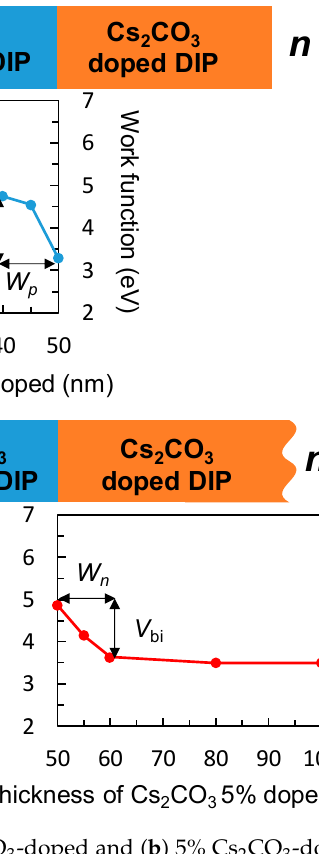
Figure 3. Work function (WF) of ( a ) 5% MoO 3 -doped and ( b ) 5% Cs 2 CO 3 -doped diindenoperylene (DIP) films on the Cs 2 CO 3 -doped film and MoO 3 -doped film, respectively, as a function of the thickness.